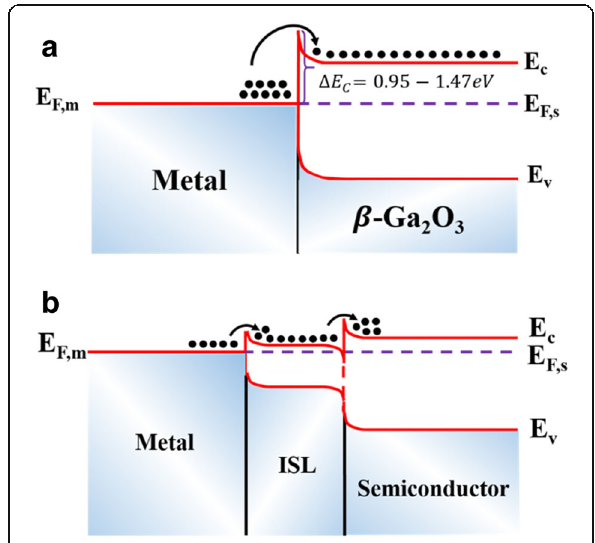
Fig. 11 The schematic of band offsets for a metal/ β -Ga 2 O 3 and b metal/ISL/ β -Ga